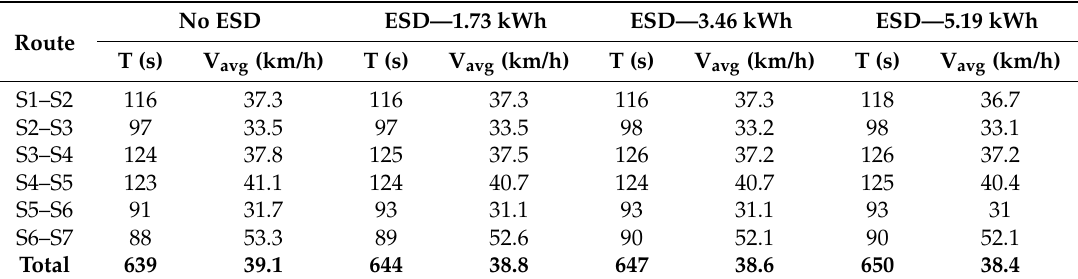
Table 4. Simulation results.